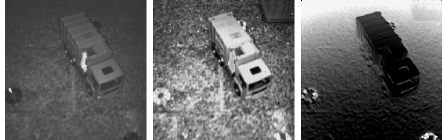
Figure 1: Image representation of normalized active intensity, normalized passive intensity and range data.